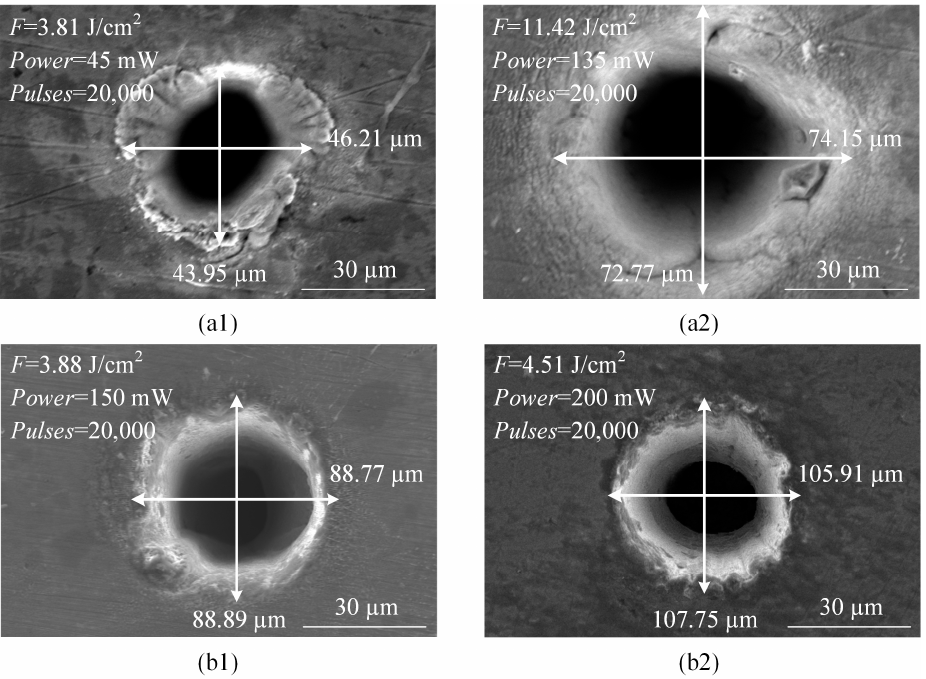
Figure 5. Hole diameter versus laser wavelength ( a1–a2 ): 532 nm wavelength, D beam = 38.8 μ m ( b1 – b2 ): 1064 nm wavelength, D beam = 75.2 μ m.